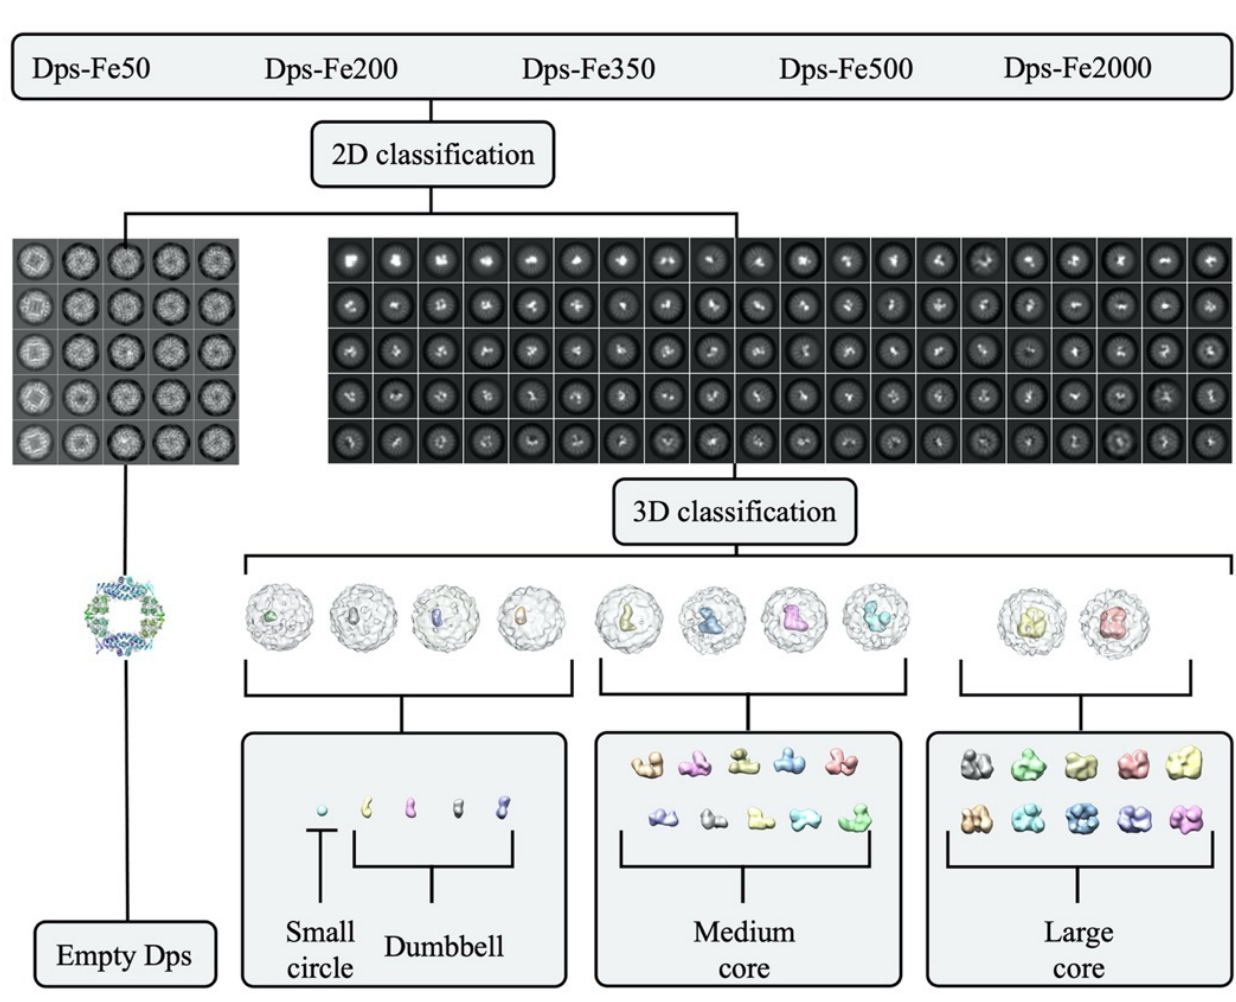
Figure 7. Cryo-EM data curation scheme.